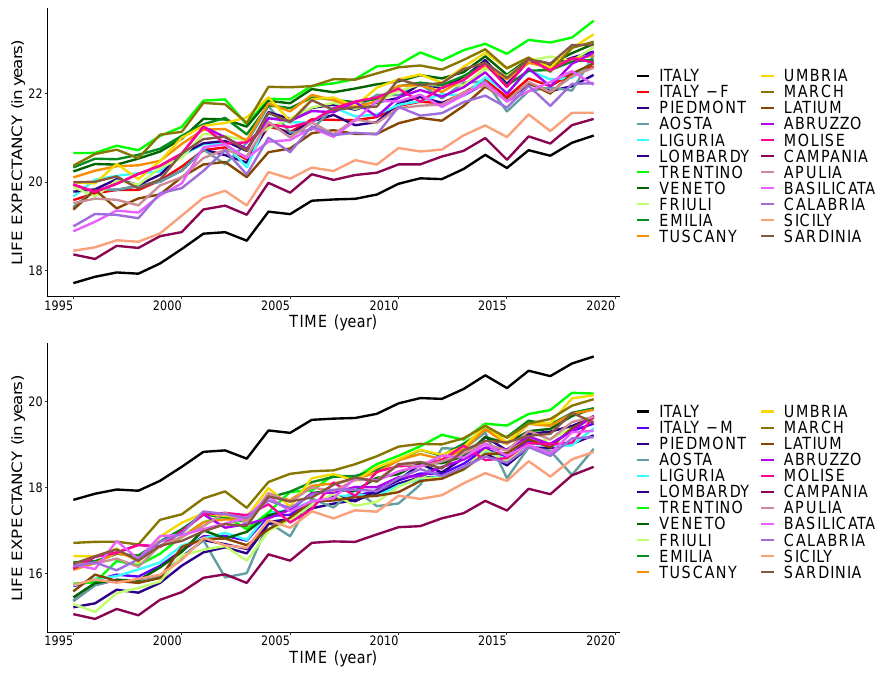
Figure A1. Life expectancy for Italian female (top) and male (bottom) population aged 65 from 1995 to 2019 across regions (NUTS-2 level). Source: author’s own elaboration on data from ISTAT.